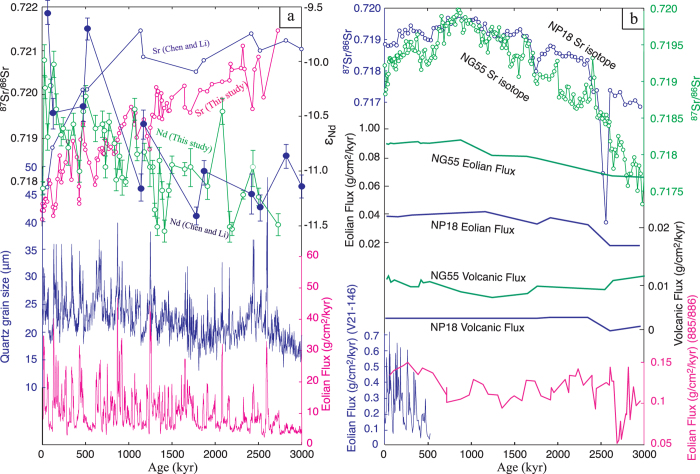
Comparison of Sr-Nd isotopic evolution with other records of the Chinese Loess Plateau and Pacific cores. a, Map shows the evolutions of Sr and Nd isotopic compositions of eolian deposits of the Xifeng section (this study), Lingtai section14 and Quartz grain size3031 and eolian flux38 of the Xifeng section on the CLP; b, Map shows the evolutions of Sr isotopic compositions and the eolian flux and volcanic ash flux in Pacific sediments29, and also the eolian flux of other two Pacific sites, V21–14646 and 885/88547.